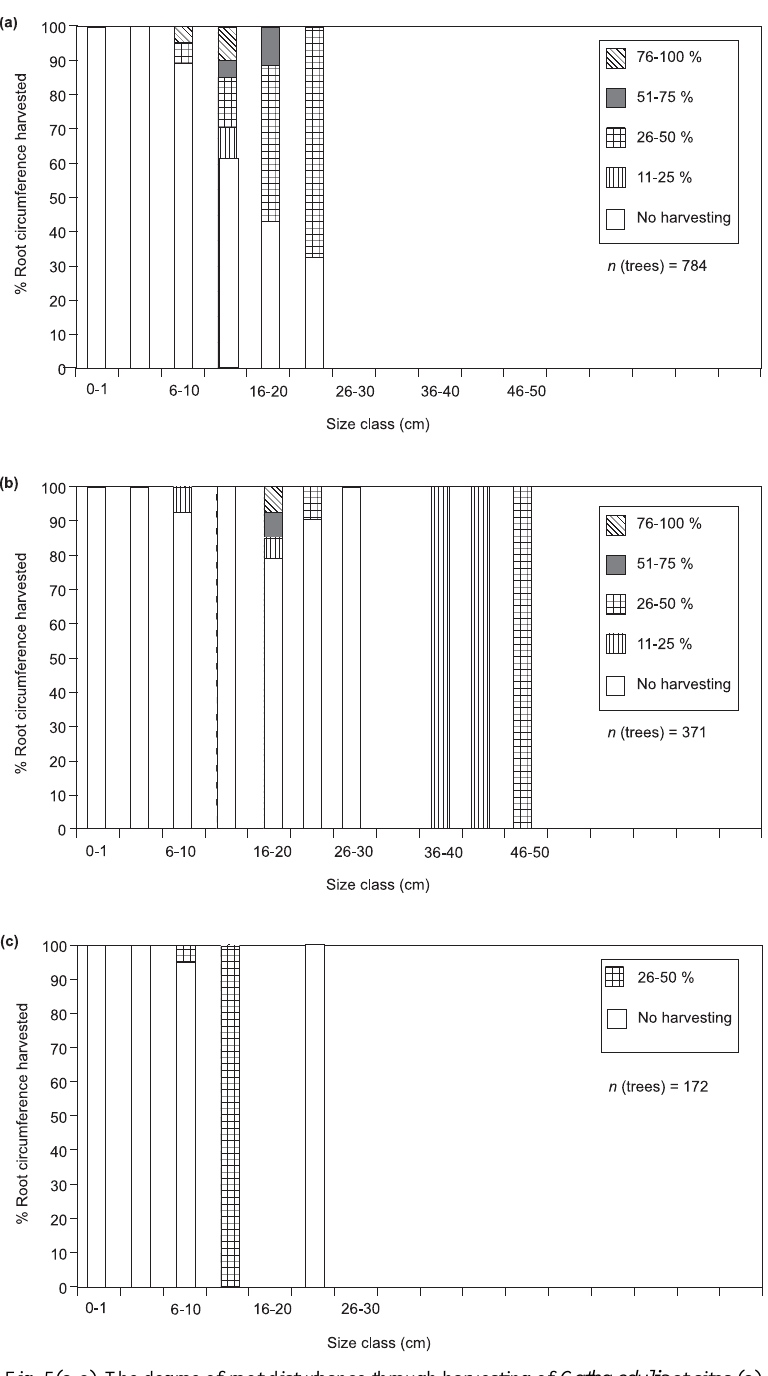
Fig. 5(a-c). The degree of root disturbance through harvesting of Catha edulis at sites (a) adjacent to a village and (b) in a forestry plantation near Barberton; (c) on communal land